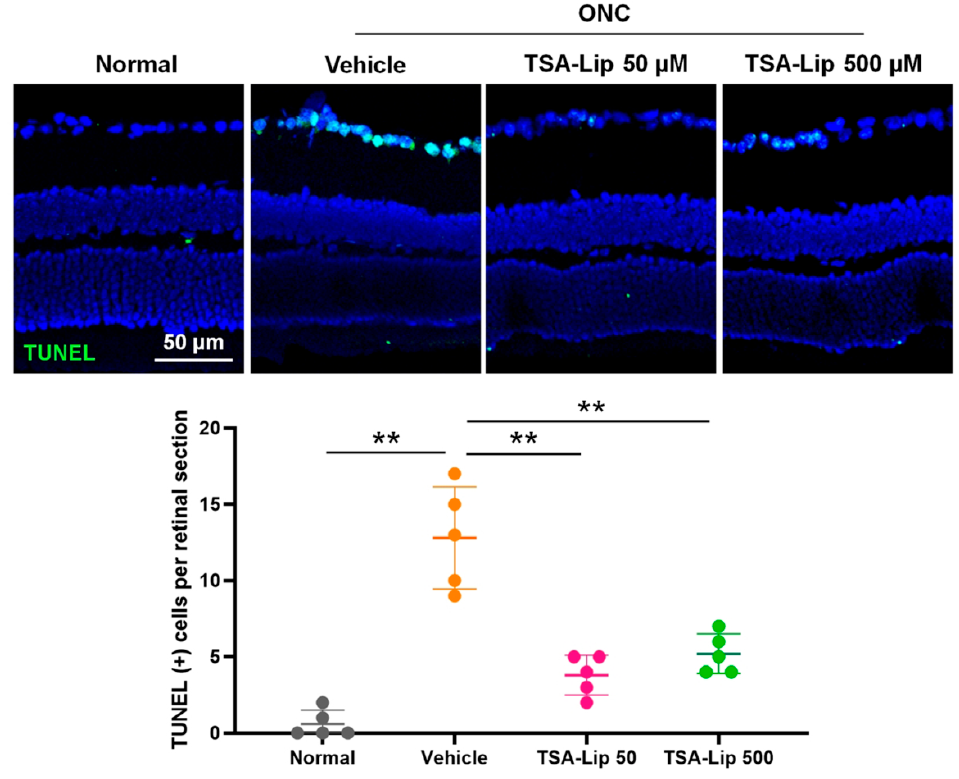
Figure 7. TUNEL staining was performed on retinal sections 7 days after ONC. Vehicle-injected retinas demonstrated significantly higher TUNEL-positive apoptotic cells in RGC layer after ONC (** p < 0.001, compared to the uninjured normal eyes). The intravitreal injection of TSA-loaded liposomes immediately after ONC injury, suppressed RGC apoptosis (** p < 0.001, compared to the vehicle group). There were no significant differences in TUNEL-positive apoptotic cells between the groups with 50 μ M and 500 μ M TSA-loaded liposomes. Images with lower magnification are presented in Supplementary Figure S3. TSA - Lip 50 μ M = liposomes loaded with 50 μ M TSA; TSA - Lip 500 μ M = liposomes loaded with 500 μ M TSA. All comparisons were performed using one-way ANOVA with post-hoc LSD test.